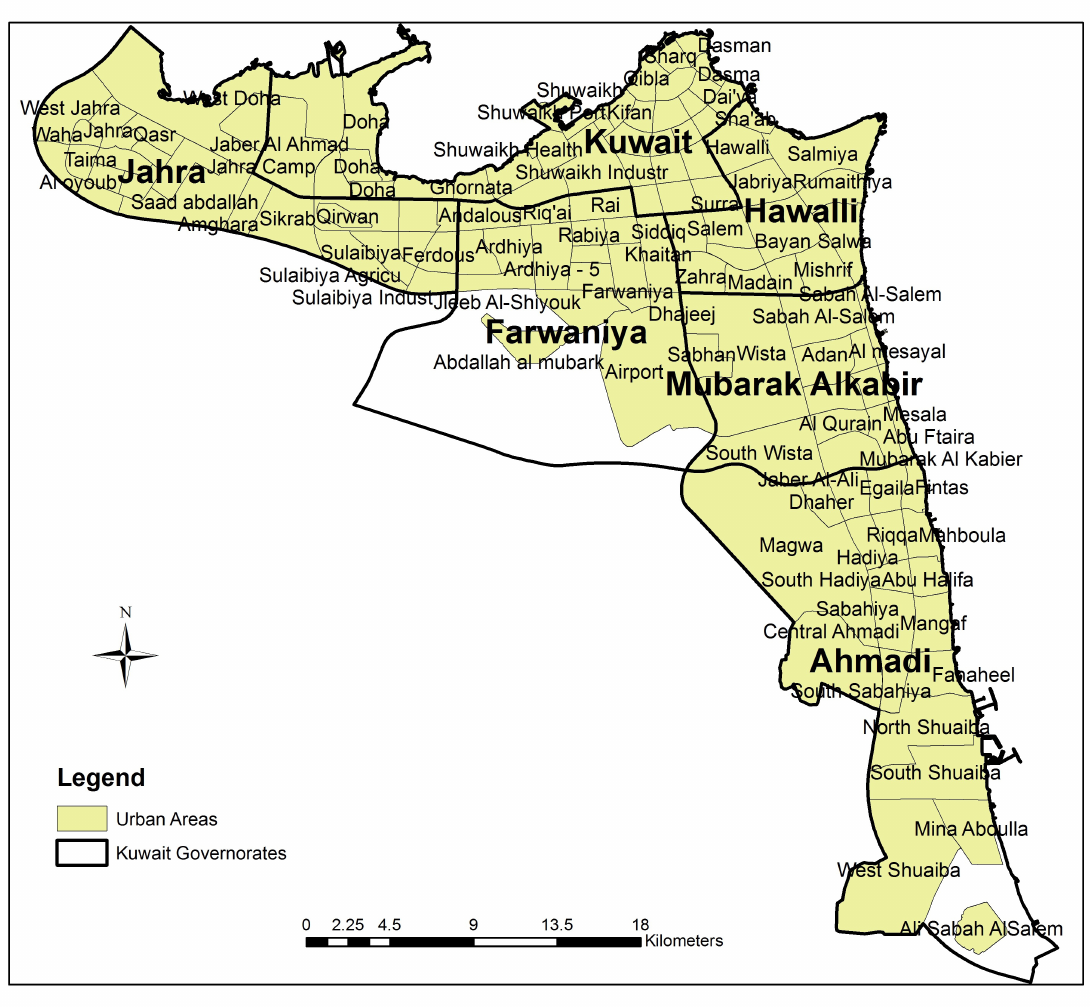
Figure A1. Urban areas in Kuwait with their corresponding